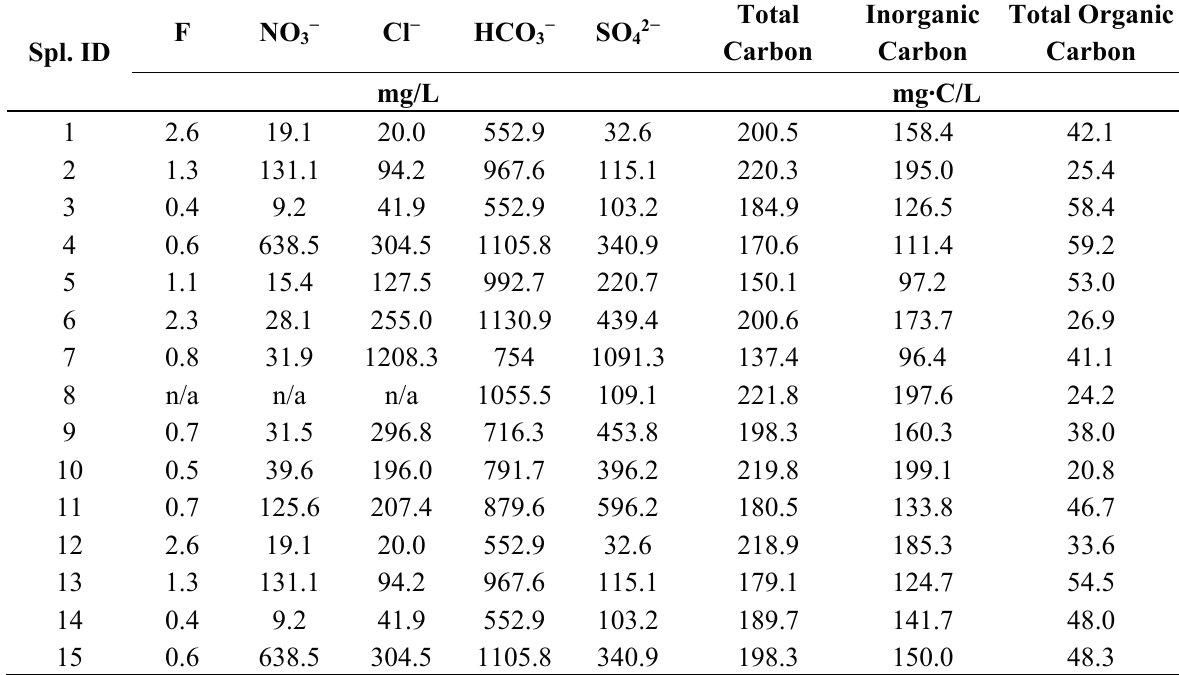
Table A5. Water quality data of 15 groundwater samples taken near Rafaela, Santa Fe province, Argentina (UTN, Rafaela and Buenos Aires,